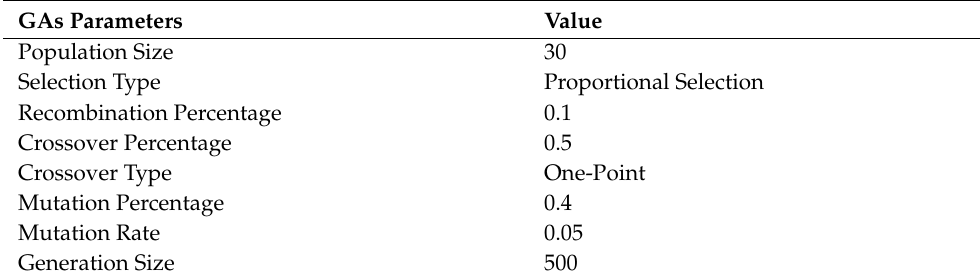
Table 1. GAs Parameter Settings.